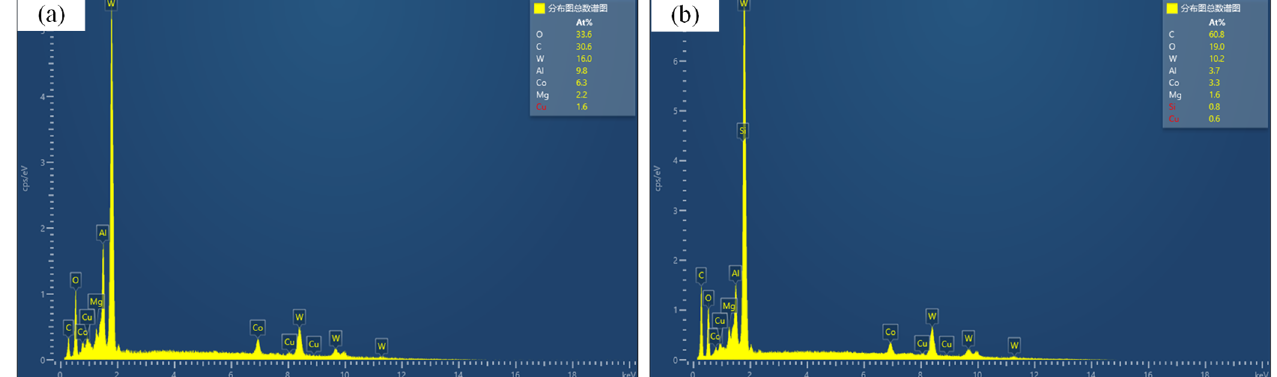
Figure 15. EDS analysisof cutting fluid ( a ) CCF-10, ( b ) QC-2803.